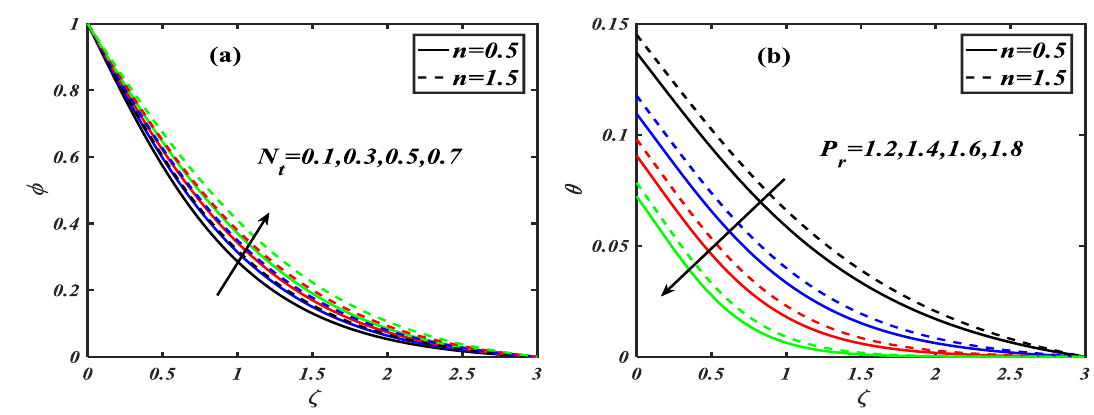
Figure 8. ( a ) Depicts thermophoresis on φ(ζ) while ( b ) depicts Prandtl number on θ(ζ) .